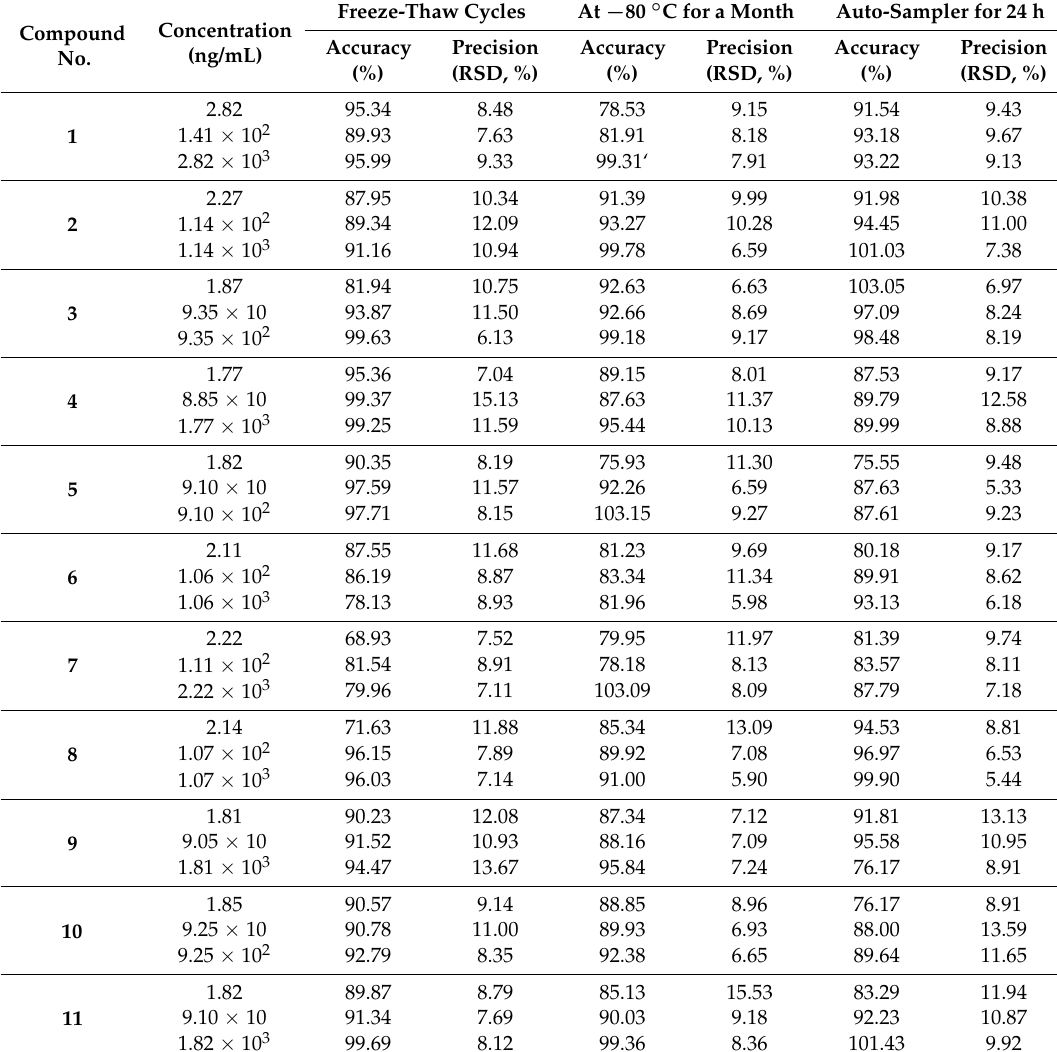
Table 5. Stability of the eleven compounds in rat